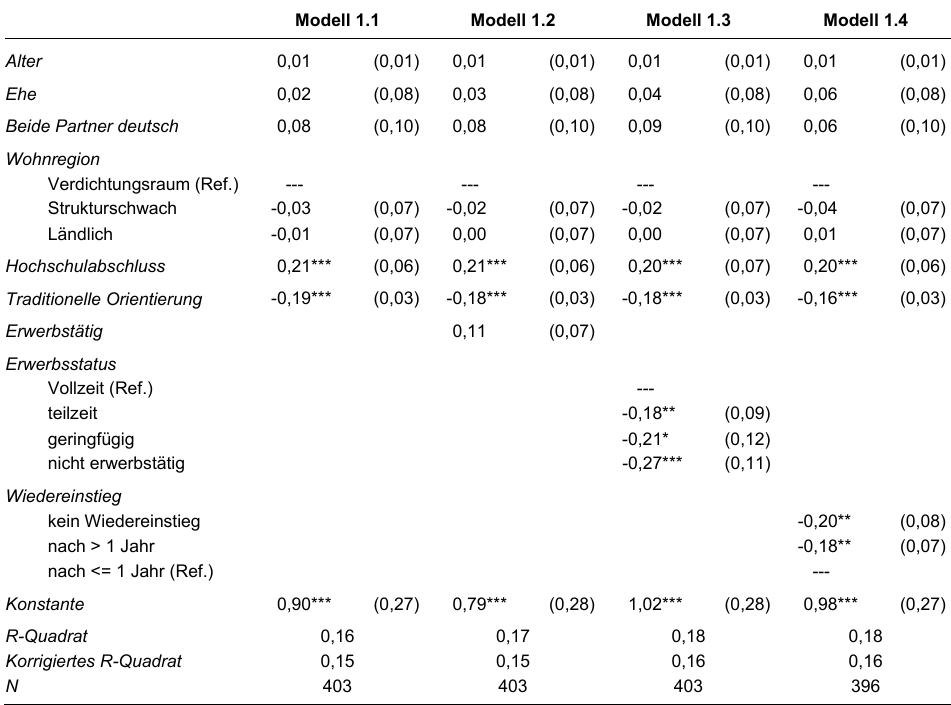
Tabelle 1: Ergebnisse der linearen Regression zur Hausarbeitsteilung Modell